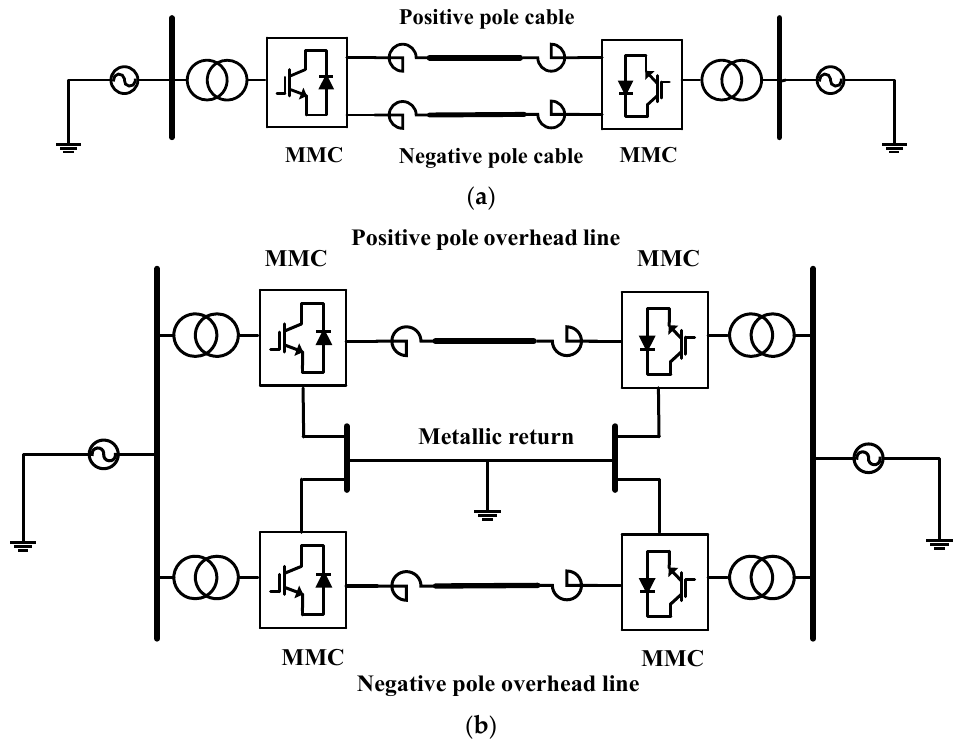
Figure 1. Diagram of the modular multilevel converter-based high-voltage direct current system in ( a ) monopolar symmetrical wiring and ( b ) bipolar symmetrical wiring.